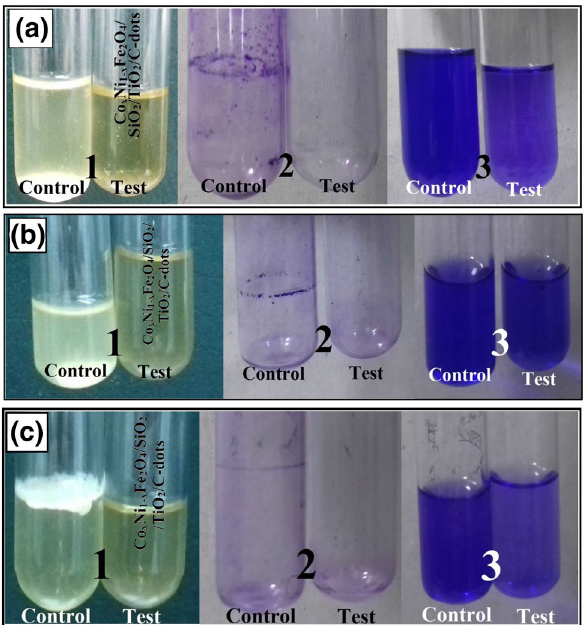
Figure 17. Antibiofilm activity of Co x Ni 1−x Fe 2 O 4 ; x = 0.9/SiO 2 /TiO 2 /C-dots nanocomposite. (15 µg/ml) using tube method against ( a ) Escherichia coli, ( b ) Bacillus cereus and ( c ) Candida tropicalis , showing (1) Growth of the bacterial and yeast cells and biofilm formation (rings) without nanocomposite treatment and the inhibition of bacterial and yeast growth after treatment, (2) Staining of the adherent bacterial and yeast cells with crystal violet and (3) Removal and dissolution of the adherent bacterial and yeast cells by ethanol for semi-quantitative biofilm inhibition determination (as shown in Table 2).